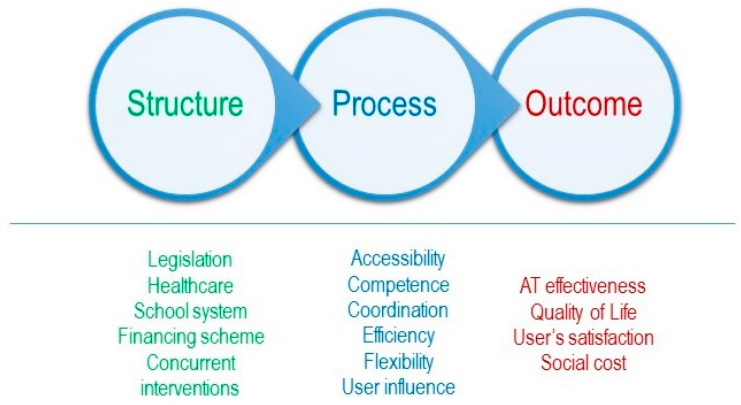
Figure 1. Framework for AT service delivery quality assurance (for details see [20,25]).